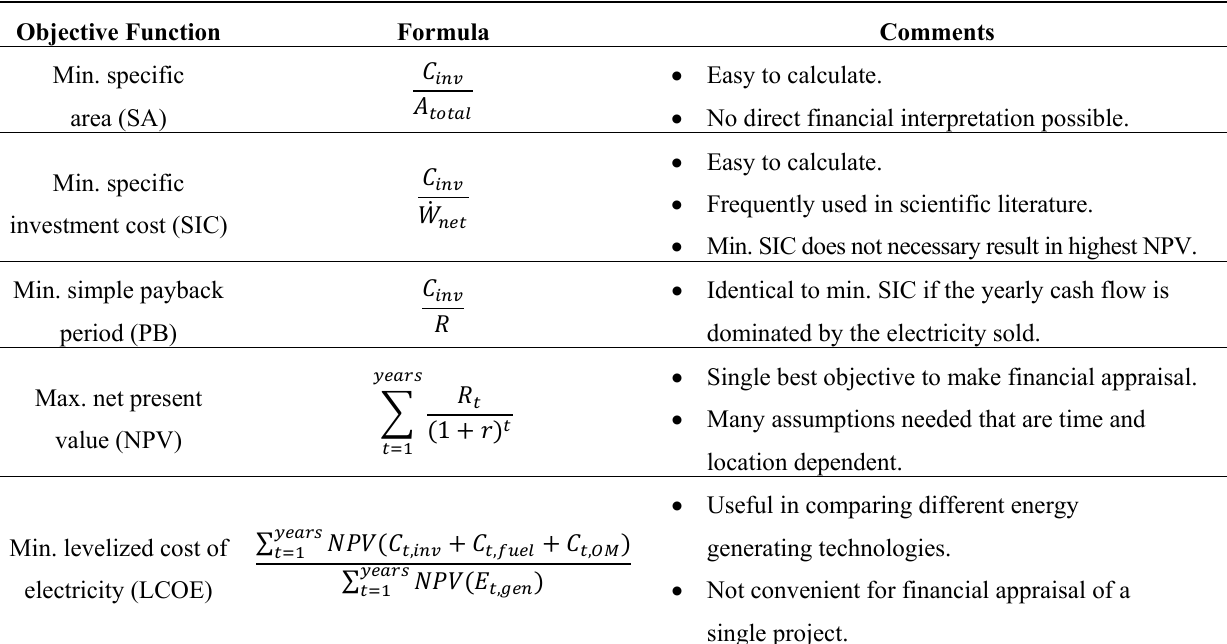
Table 2. List of objective functions used in thermo-economic